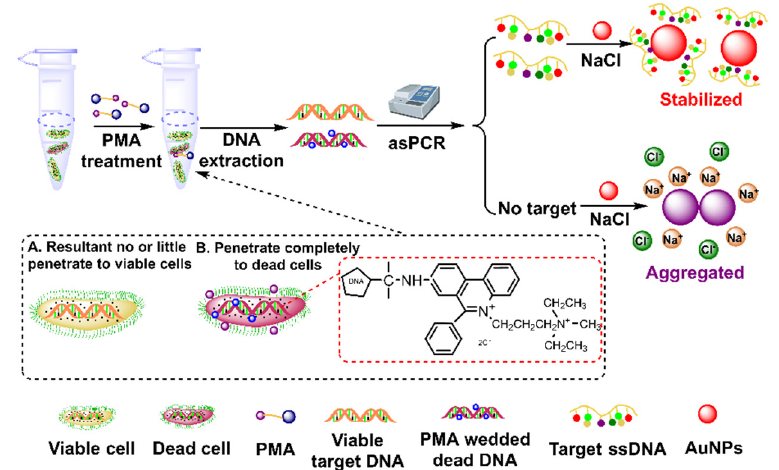
Figure 3. Schematic diagram of the colorimetric detection of viable emetic Bacillus cereus based on PMA-As PCR and AuNPs. Adapted with permission from ref [60]. Copyright 2018 Elsevier. Beyond health-related DNA and proteins, AuNPs and PCR were also combined for the detection of prostate cancer urinary biomarker PCA3 , a non-coding RNA [62]. The thiol forward primer was used and the presence of PCA3 generated the thiolated PCA3 PCR products, which were further modified on AuNPs and stabilized AuNPs in the salt